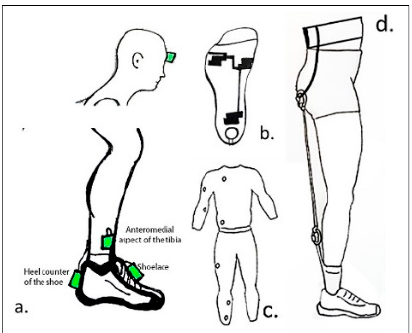
Figure 2. Schematic of wearable devices. ( a ) Representation of accelerometers and IMU placed in one or two body parts; ( b ) a heel-force resistive sensor and three embedded conductive sensors were placed in a sock connected; ( c ) a full-body compressive suit; ( d ) running belt device applying 5 kg resistance.